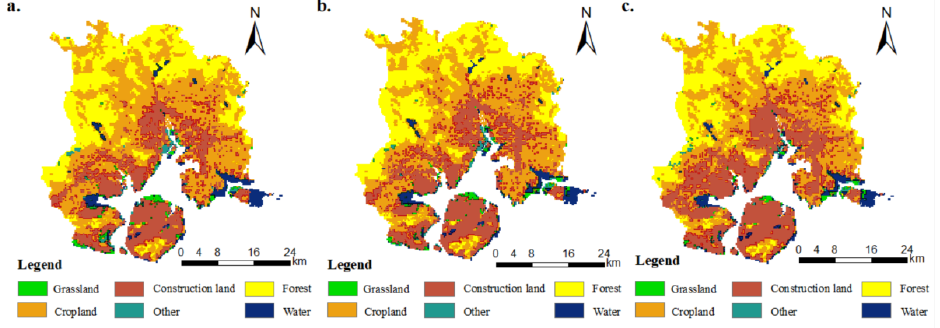
Figure 3. Land cover map of Xiamen in 2010 to 2020: ( a ) 2010; ( b ) 2015; and ( c ) 2020. Table 3. LUCC in Xiamen from 2010 to 2020 (unit: km 2 ).